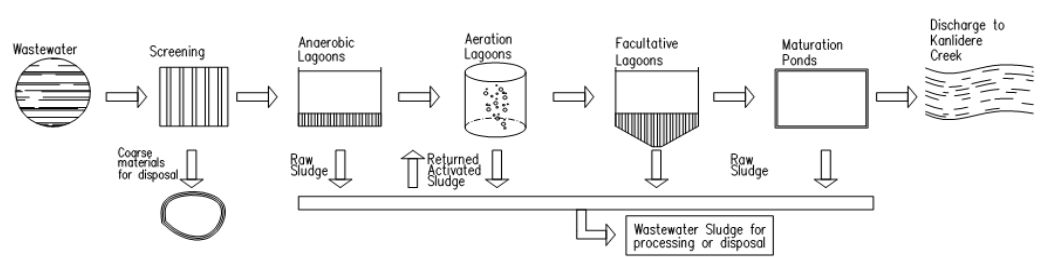
Figure 6. Wastewater treatment flowchart of the Lefkosa Central Treatment Plant.